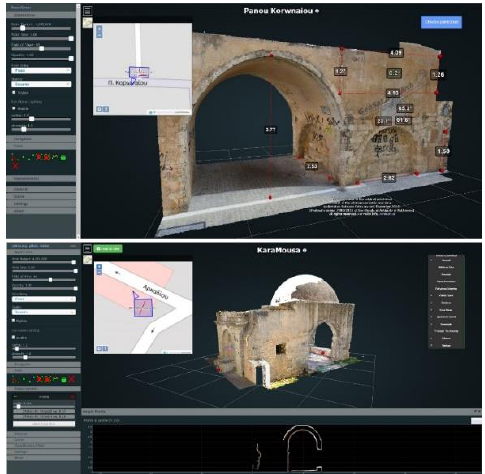
Figure 3: Two examples of possible measurements and analyss on the web-portal of “Water in Crete”; Ottoman fountain “Panou Koronaiou” (on top) with linear and area measurements and Kara Mousa (bottom) with a cross section (red line on the cloud) and its profile representation.